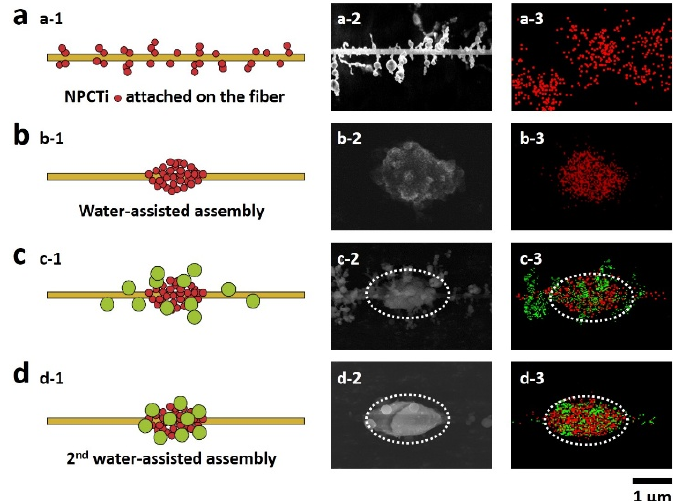
Figure 2. Illustrations and SEM images of the multi-scale heterogeneous hump-on-string fiber. ( a ) NPCTi are adsorbed onto the smooth PMMA fiber; ( b ) the Ti-humps are fabricated after the 1st wet-assisted assembly; ( c ) NPCAl are adsorbed onto the fiber with Ti-humps; ( d ) the multi-scale heterogeneous hump-on-string fibers are formed after the 2nd wet-assisted